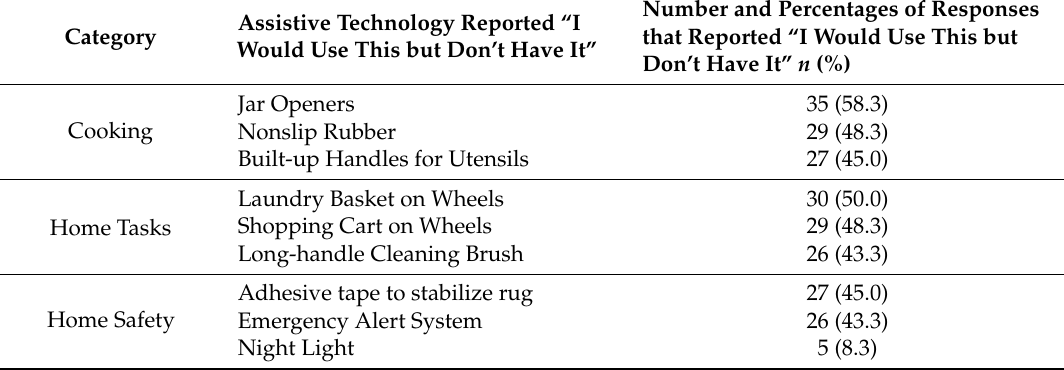
Table 4. Most frequently identified devices in the top three categories of assistive technology identified as “I would use this but do not have it”.